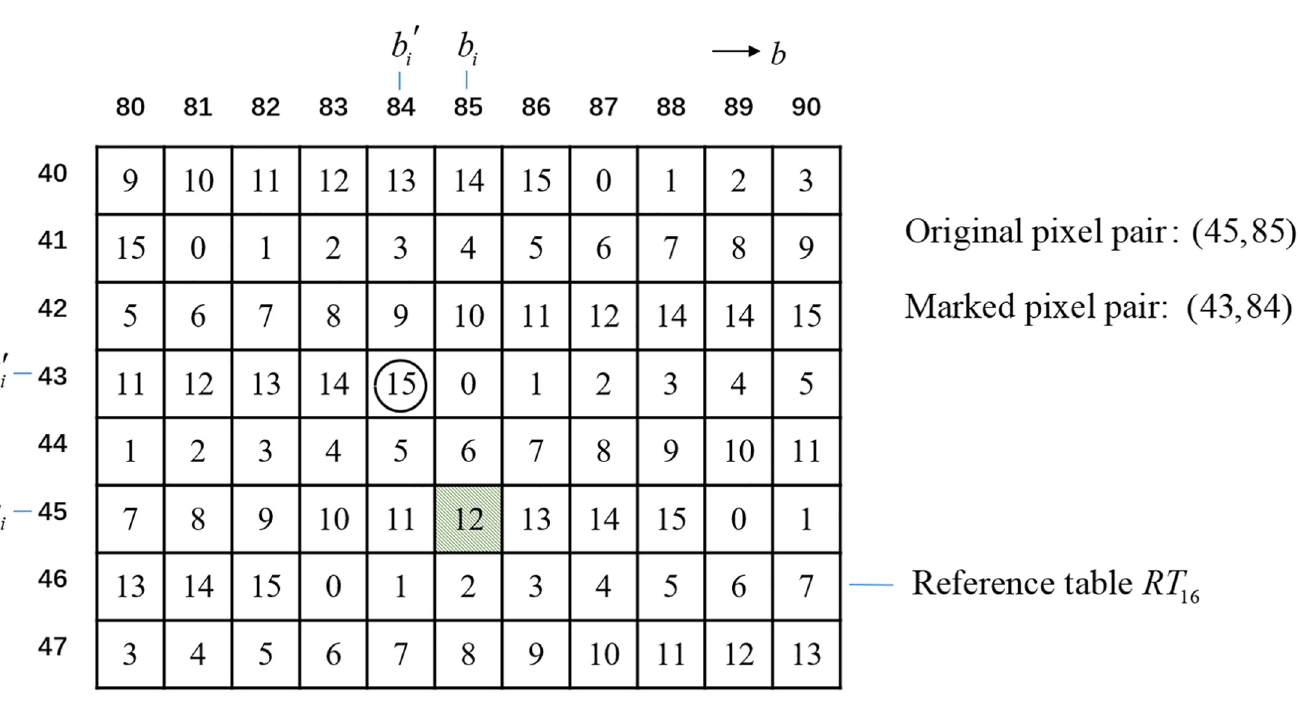
Fig 2. An example of the APPM method.